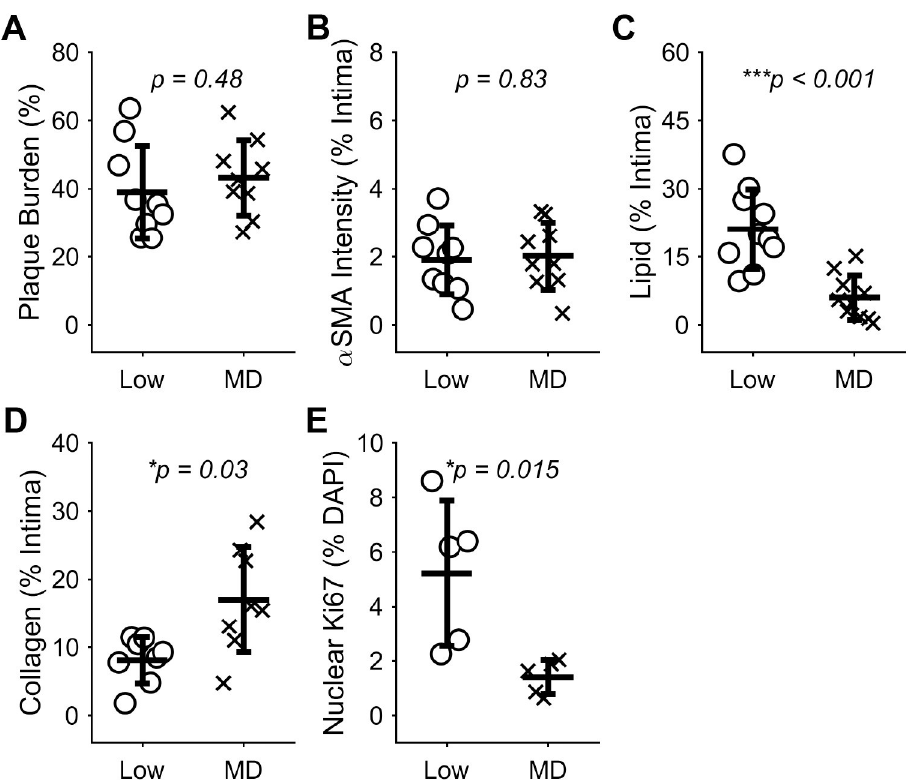
Fig 10. Characteristics of plaques induced by low WSS compared to multidirectional (MD) WSS. Plaque size and constituents assessed over the whole plaque, including: (A) Plaque burden ( n = 10 mice), (B) α -SMA intensity ( n = 10), (C) lipid ( n = 10), (D) collagen ( n = 8), and (E) area of Ki67 in the nucleus of cells normalized by total cell nuclear (DAPI) area ( n = 5). Each data point of each plot represents the average of a given readout across all viable histological sections in each vessel segment of one mouse. Bars are mean ± SD. � P < 0.05 is considered statistically significant.